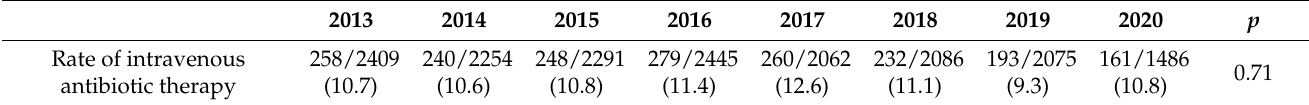
Table 6. Patients administered intravenous antibiotics after oral quinolone prescriptions as